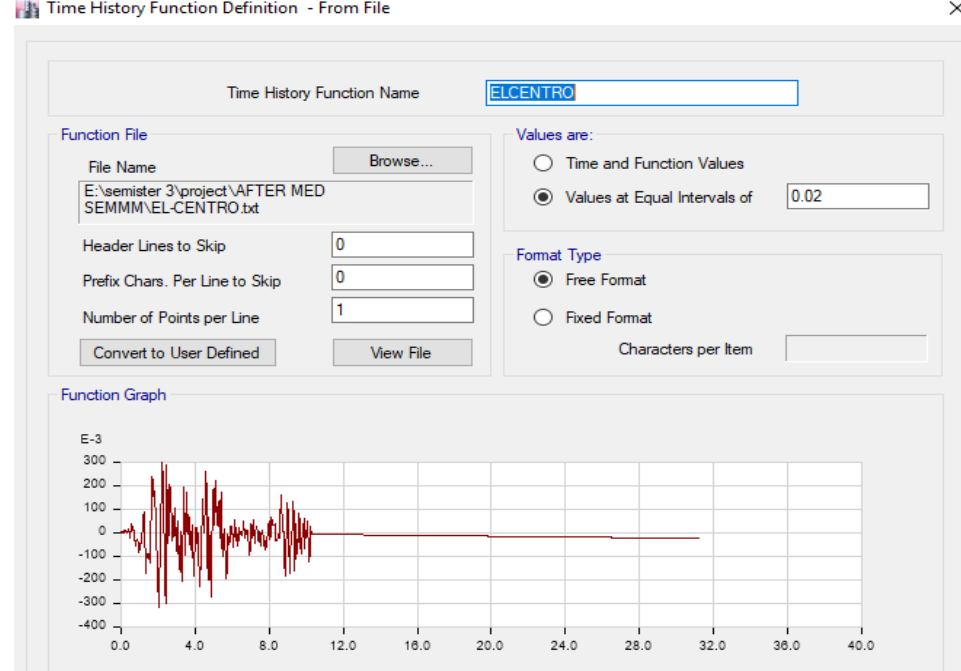
Figure 6. Time history function definition.